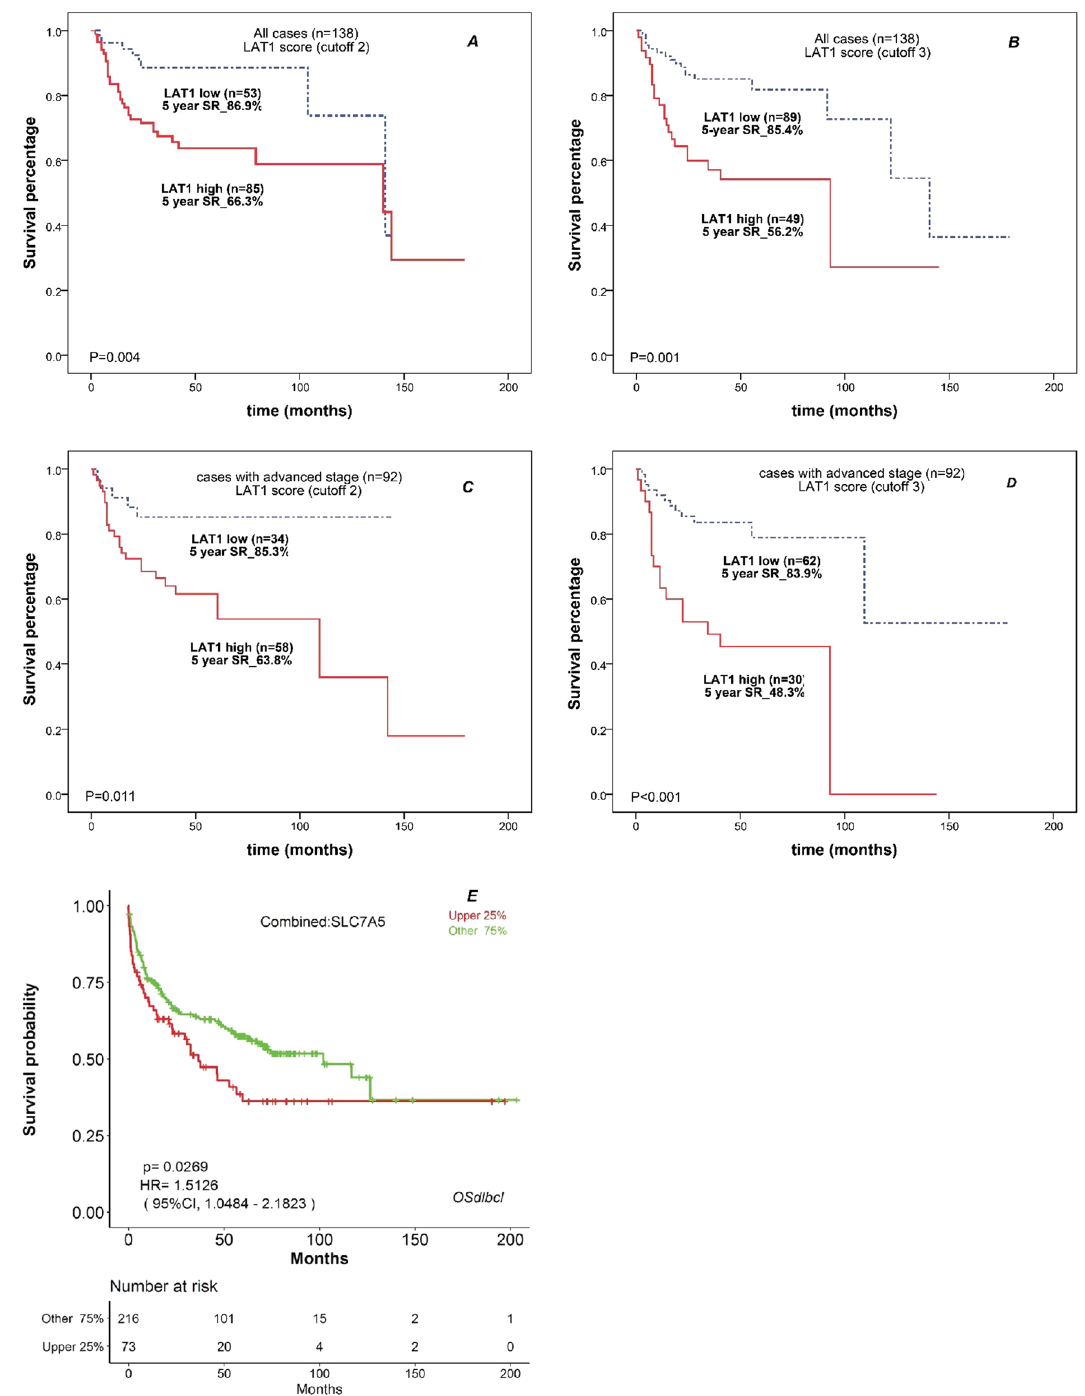
Figure 7. Higher LAT1 expression is a diagnostic marker for the poorer survival rate of patients with NHL. ( A , B ) Overall survival curves of patients with NHL divided by LAT1 scores with cutoffs of 2 ( A ) and 3 ( B ). ( C , D ) Overall survival curves of patients with advanced stage of NHL divided by LAT1 scores with cutoffs of 2 ( C ) and 3 ( D ). In all log-rank tests, outcomes were significantly poorer in the LAT1-high group than in the LAT1-low group. ( E ) Kaplan–Meier survival curve according to the gene expression of SLC7A5 in OSdlbcl web server. The survival analysis used the combined cohort and gene expression cutoff value set of 25%. The OS of the group with cutoff value upper 25% was poorer than the other